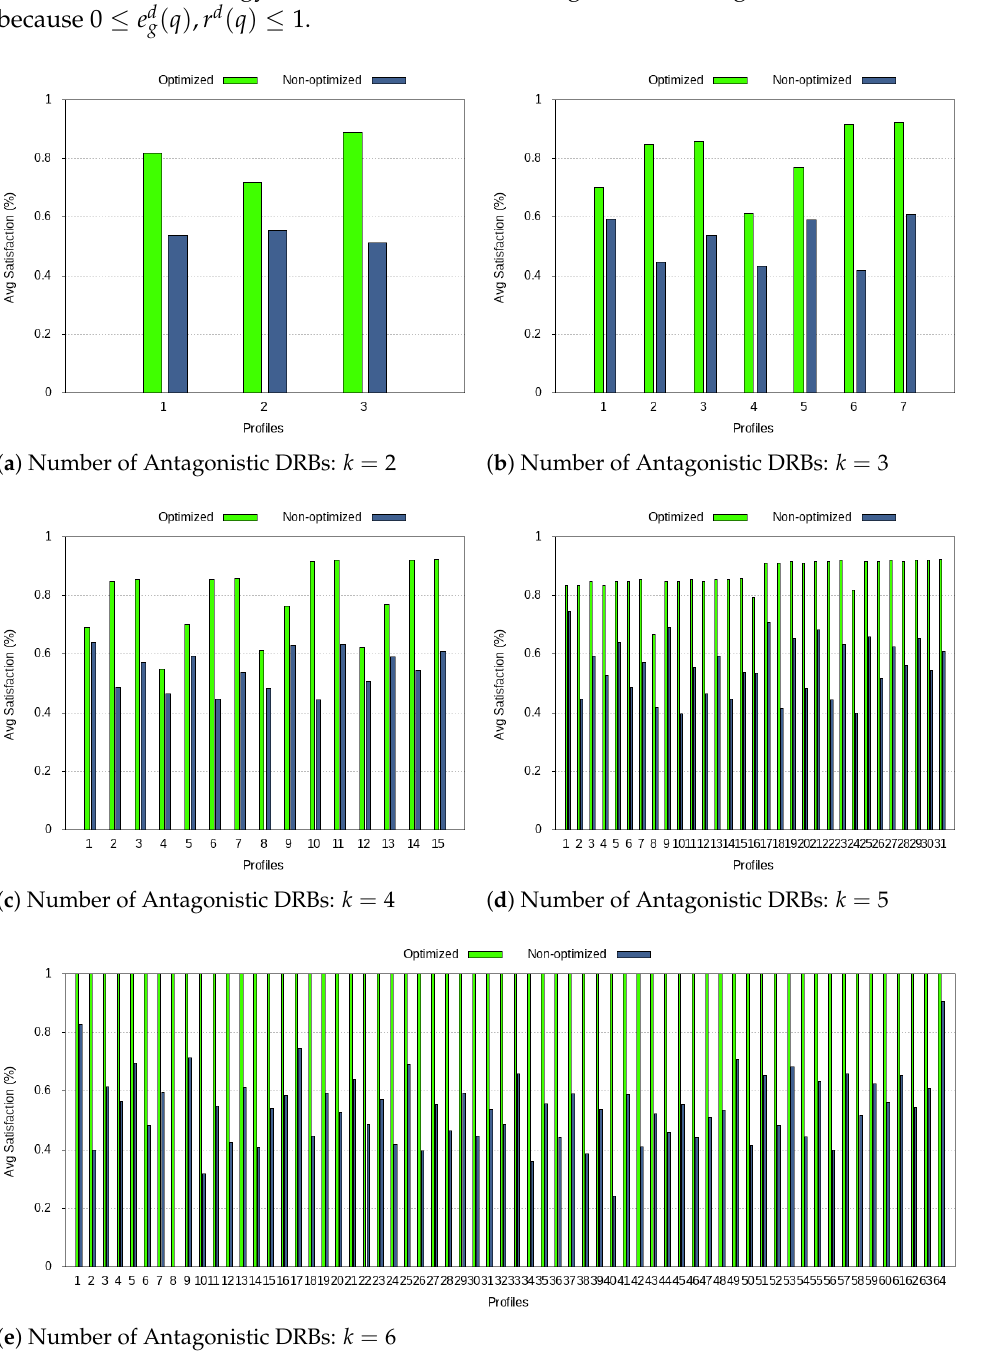
Figure 5. Average satisfaction of QoS